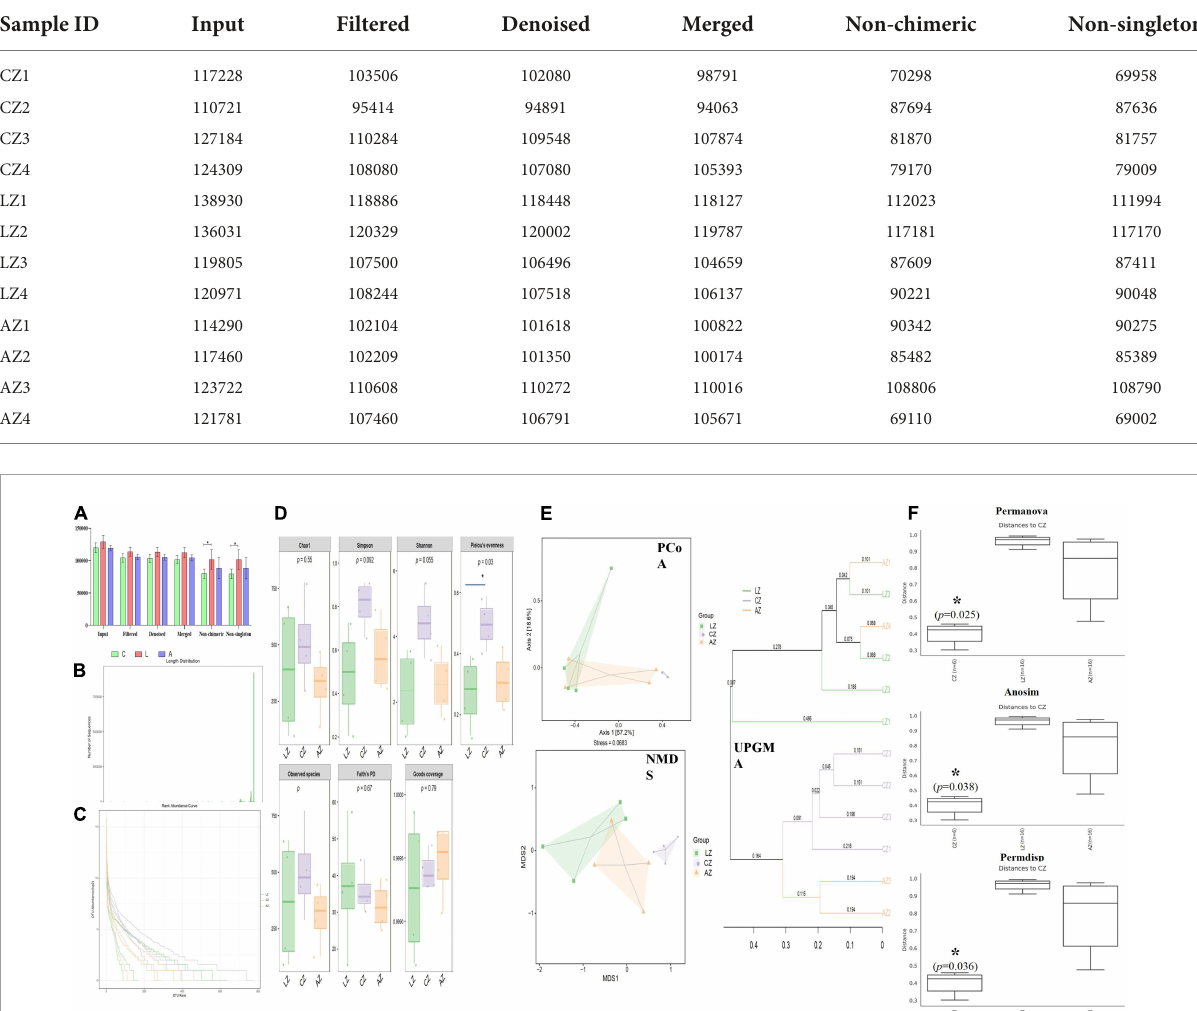
TABLE 2 Statistical analysis of sample sequencing data.